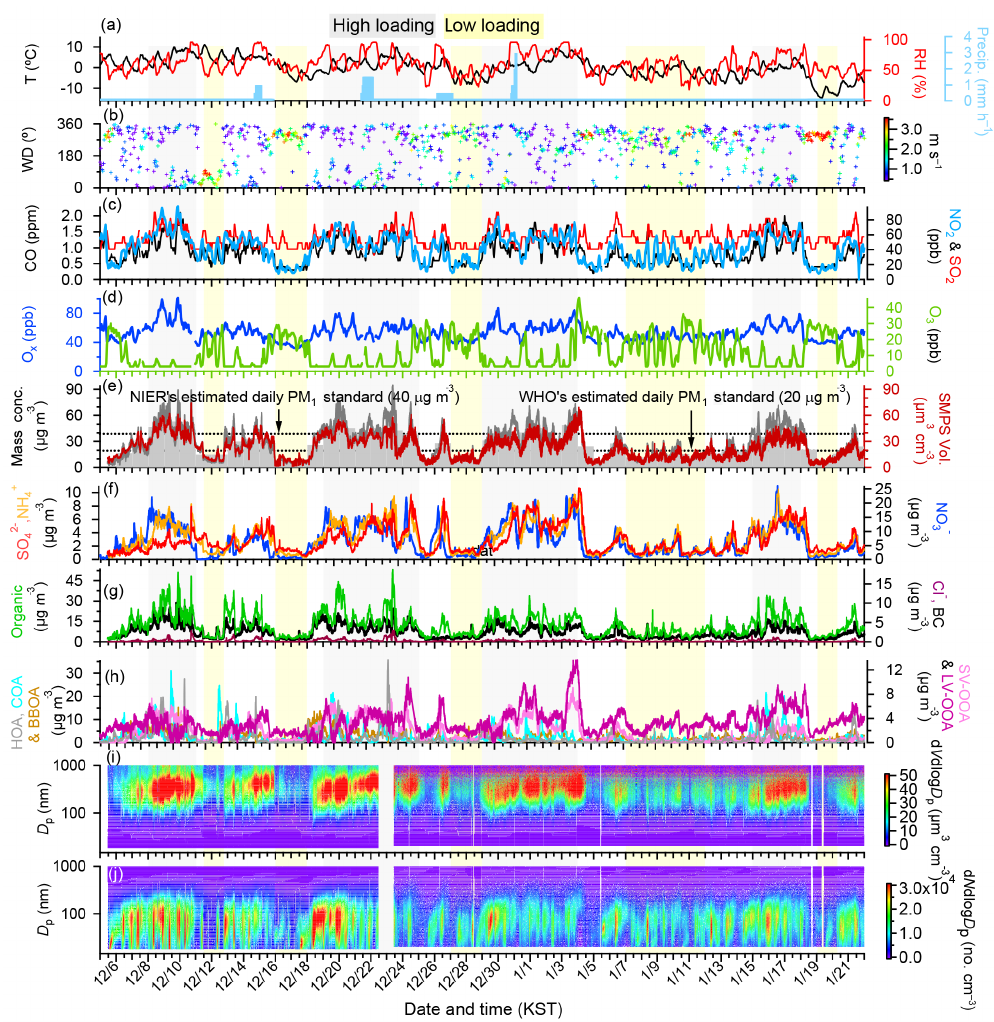
Figure 2. Overview of the temporal variations in submicron aerosols at the KIST in Seoul from 5 December 2015 to 21 January 2016. (a) Time series of ambient air temperature ( T ), relative humidity (RH), solar radiation (SR), and precipitation (Precip.); (b) time series of wind direction (WD), with colors showing different wind speeds (WS); (c) time series of CO, SO 2 , and NO 2 ; (d) time series of O x (NO 2 + O 3 ) and O 3 ; (e) time series of total particulate matter (PM 1 ), and scanning mobility particle sizer (SMPS) volume concentrations. Also shown are the 24h averaged PM 1 + BC with bars. Estimated NIER and WHO daily PM 1 standards (40 and 20µgm − 3 , respectively) are also shown as dashed lines for the comparisons; (f) time series of the organic aerosols (Org.), nitrate (NO − (Cl − ), and BC; (g) time series of the total organic aerosol (OA) of the five factors derived from the positive matrix factorization (PMF) analysis (see Sect. 3.3). (h,i) Particle volume and number size distributions by SMPS. Shaded regions indicate the persistent ( > 2 days) high-loading (gray) and low-loading (yellow) periods when daily average conc. > 30µgm − 3 and < 14µgm − 3 ,